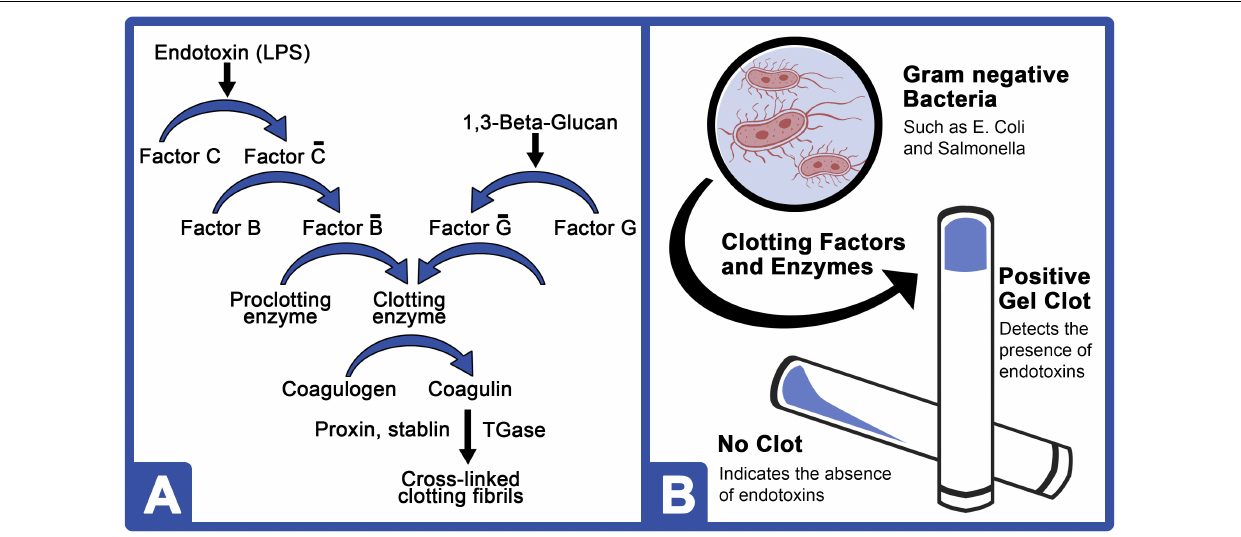
FIGURE 1 | LPS and 1,3- β - D -glucan clotting cascades of the HSC amebocyte lysate. (A) Bacterial endotoxins (LPS) activate Factor C (C-bar), which then activates Factor B (B-bar). Activated Factor B converts the proclotting enzyme to a clotting enzyme and cleaves two coagulogen peptide bonds to form an insoluble coagulin